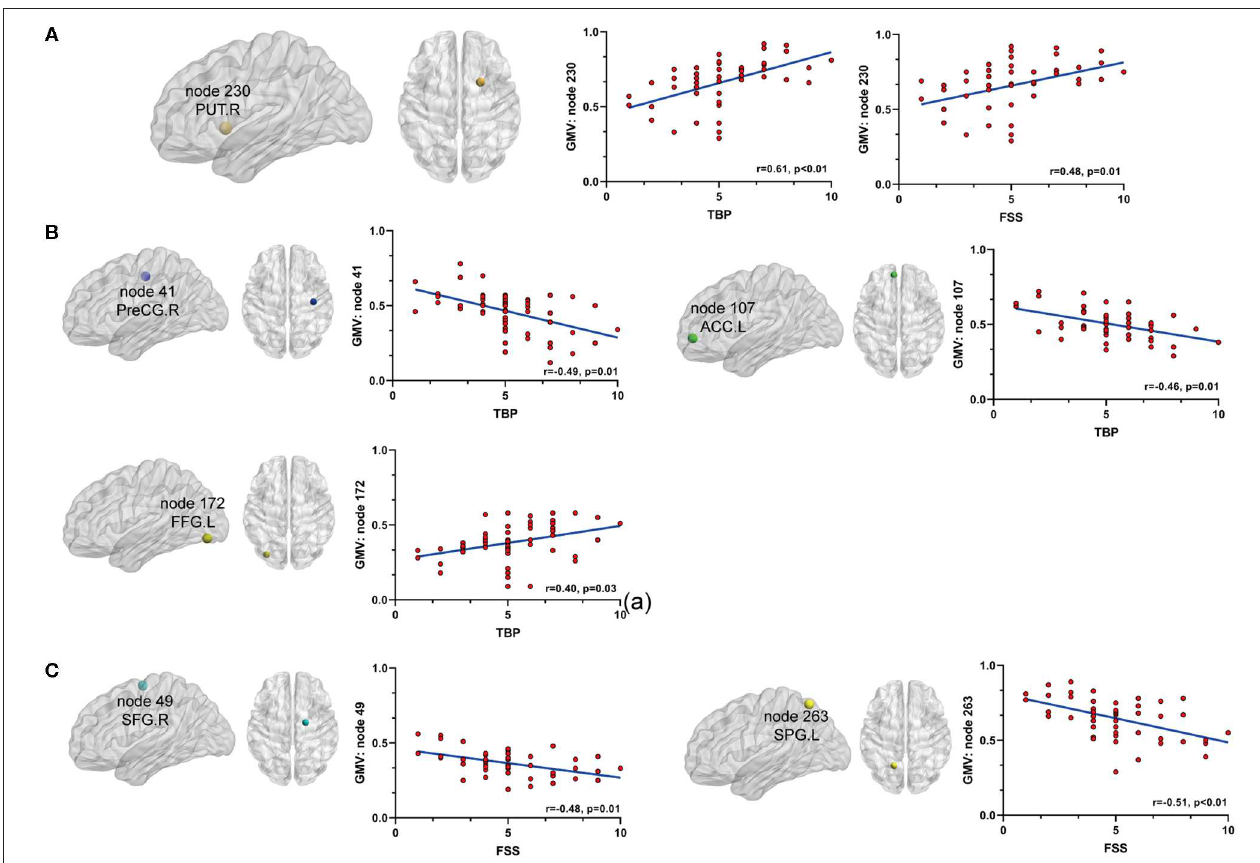
FIGURE 7 | The relationship between significant GMV changes and pain or fatigue as measured by TBP or FSS ( p < 0.05, Bonferroni corrected): (A) gray matter volume (GMV) of node 230 (PUT.R) was positively associated with both pain and fatigue; (B) GMV of node 41 (PreCG.R) and node 107 (ACC.L) was negatively associated with pain and GMV of node 172 (FFG.L) was positively associated with pain; (C) GMV of nodes 49 (SFG.R) and 263(SPG.L) was negatively associated with fatigue. PUT.R, right putamen; PreCG.R, right precentral cortex; ACC.L, left anterior cingulate cortex; FFG.L, left fusiform gyrus; SFG.R, right superior frontal gyrus; SPG.L, left superior parietal gyrus.